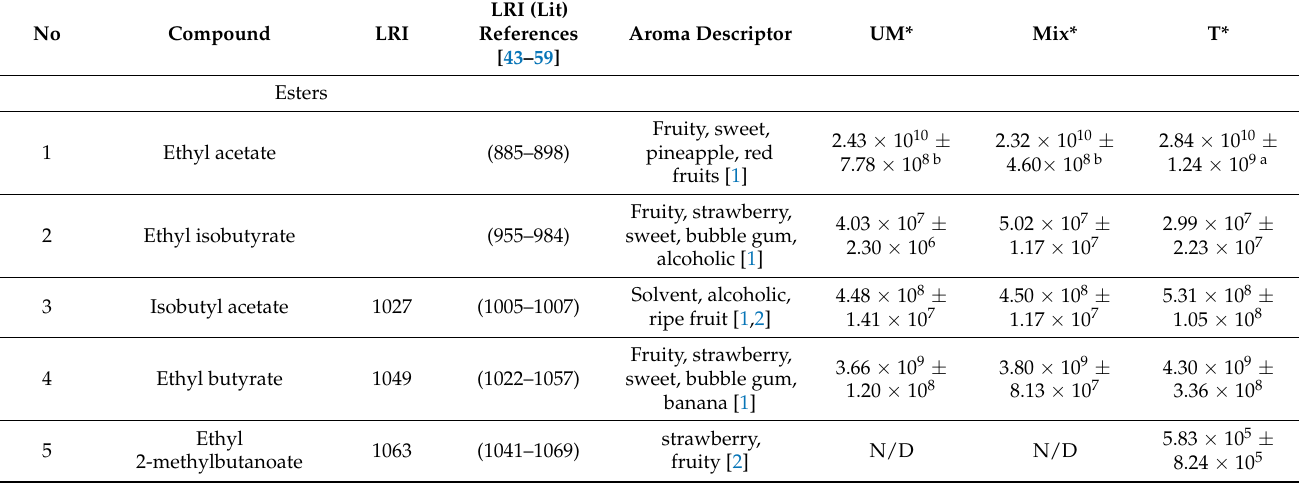
Table 3. Average area values of VOC obtained from the analysis of all Ant ã o Vaz wines and respective standard deviation of the mean: Frozen unripe grape must addition (UM*); addition of a mixed solution of tartaric, malic, and lactic acid (Mix*); testimonial wine (T*); LRI denotes calculated linear retention indices; LRI (Lit) denotes linear retention indices according to literature; Aroma descriptor denotes the aroma descriptors indicated by the literature. Different letters in the row mean statistically significant differences at p < 0.05. N/D—not